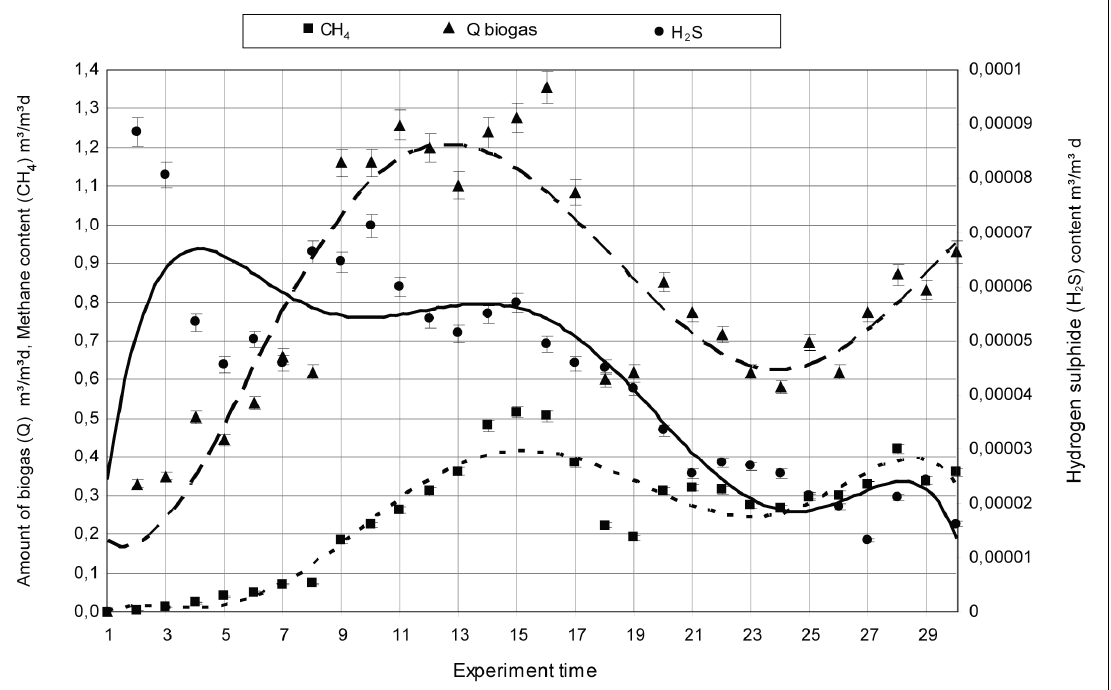
3 3 /m d), methane (m